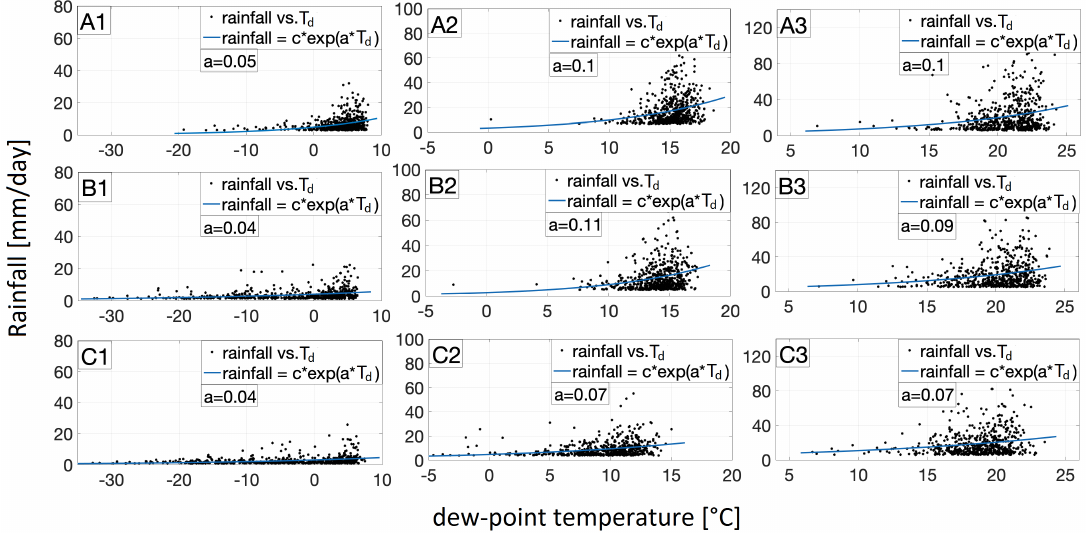
Figure 10. Scatterplot showing the dew-point temperature vs. rainfall amounts for events above 90th percentile. ( a ) in regression equation ( rainf all = c ∗ exp ( a ∗ T d )) shows the regression coefficient for the independent variable dew-point temperature for all boxes along the climatic and topographic gradients. See Figure 4A for all boxes (A1–C3). Regression coefficient ( a ) reveals a value around CC relation (0.068 ◦ C − 1 ) in all boxes.